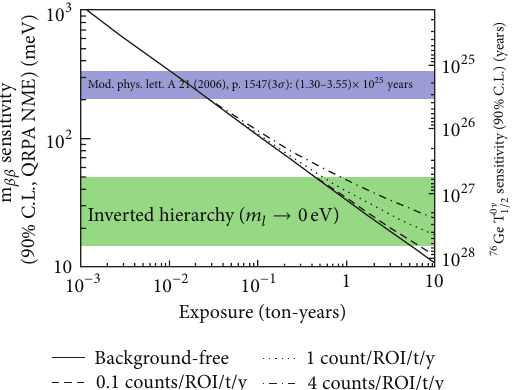
Figure 14: 90% C.L. sensitivity as a function of exposure for 𝛽𝛽(0 ] ) - decaysearchesin 76 Geunderdifferentbackgroundscenarios.Matrix elements from [71] were used to convert half-life to neutrino mass. The blue band shows the region where a signal would be detected if the recent claim [19] is